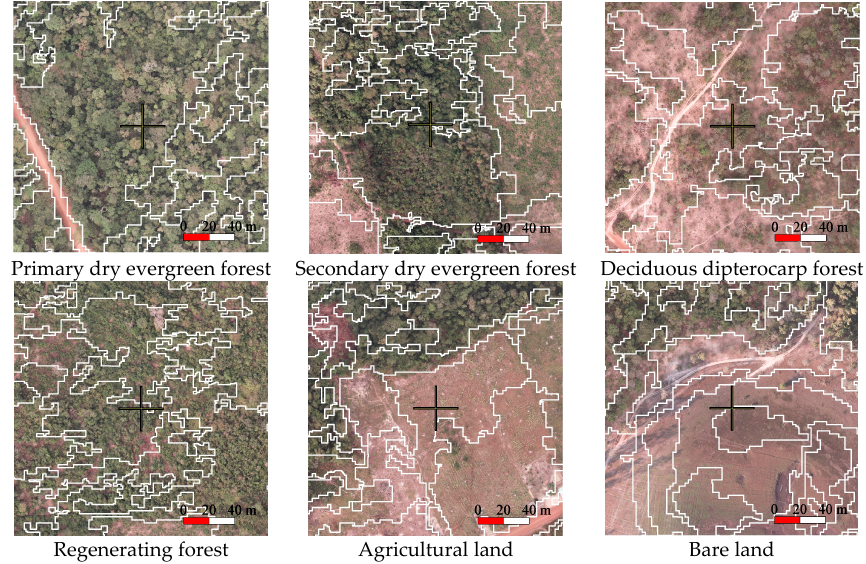
Figure 2. Interpretation of orthophotographs by the object, which includes the intersection of a 250 m × 250 m grid, produced by segmenting the images in the Section